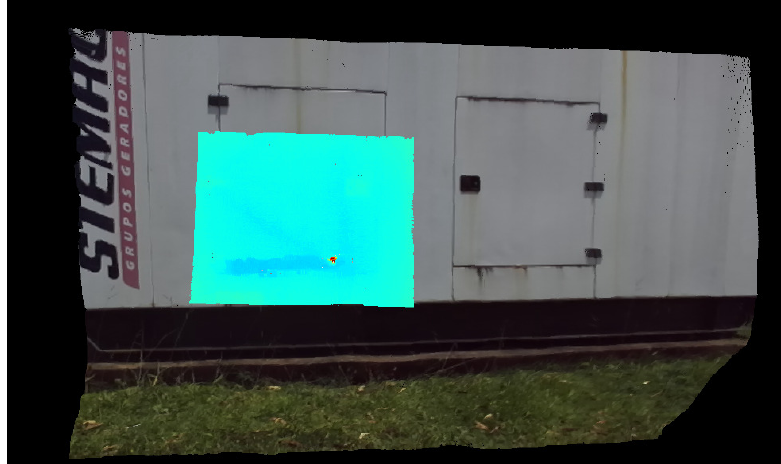
Figure 6. Instant N-Dimensional